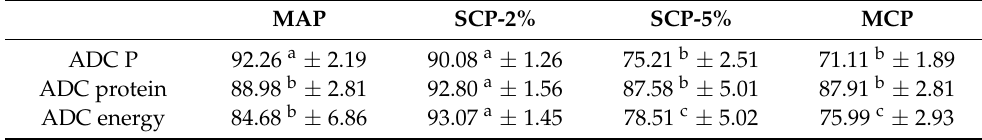
Table 3. Results of apparent digestibility coefficients (ADC, %) by treatment